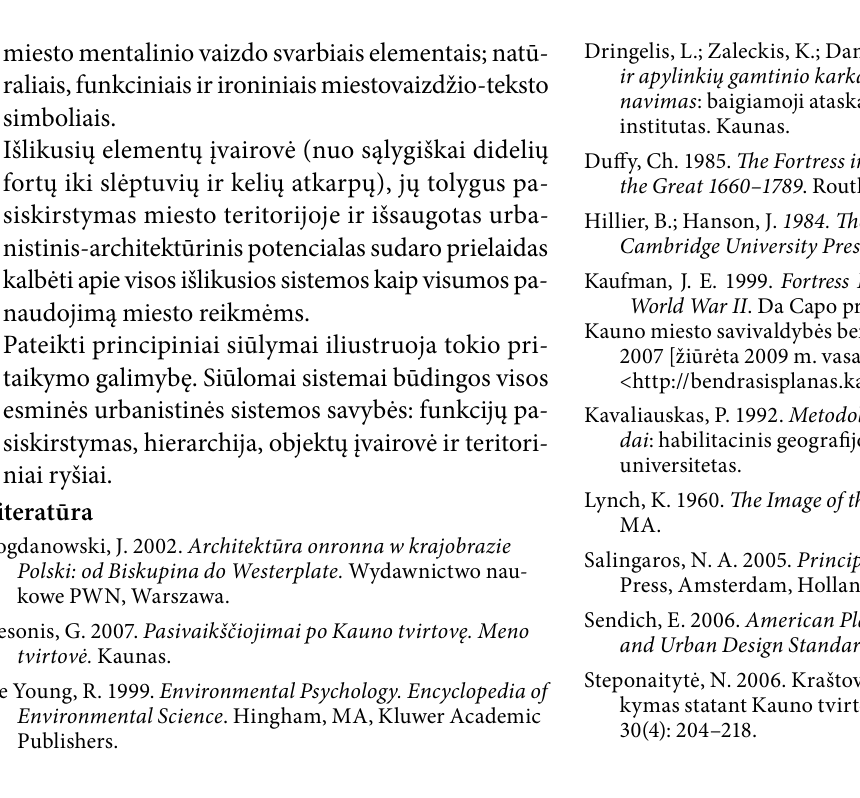
Fig. 4. recreational system of kaunas Fortress fortifications and principled proposals on making bicycle